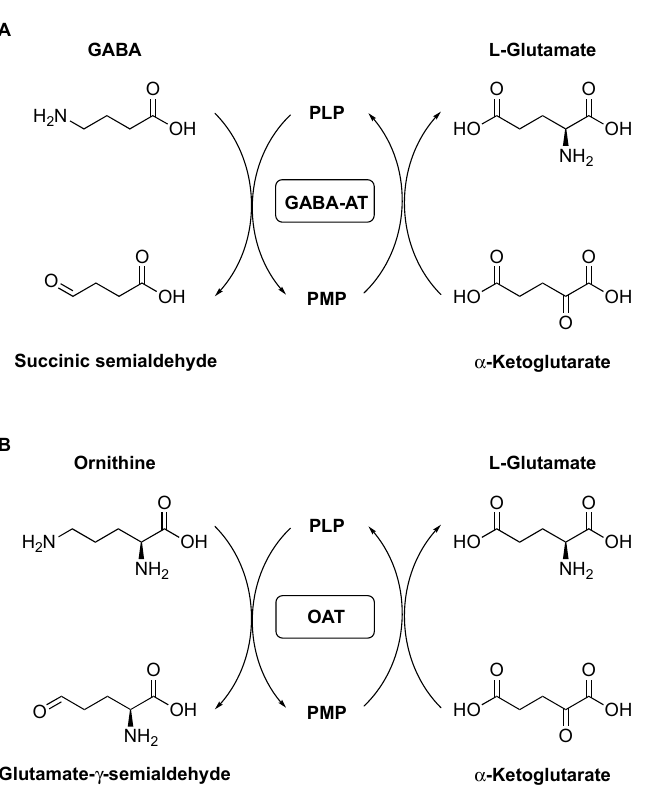
Scheme 1. Mechanisms of inactivation of GABA-AT by ( S )-vigabatrin.